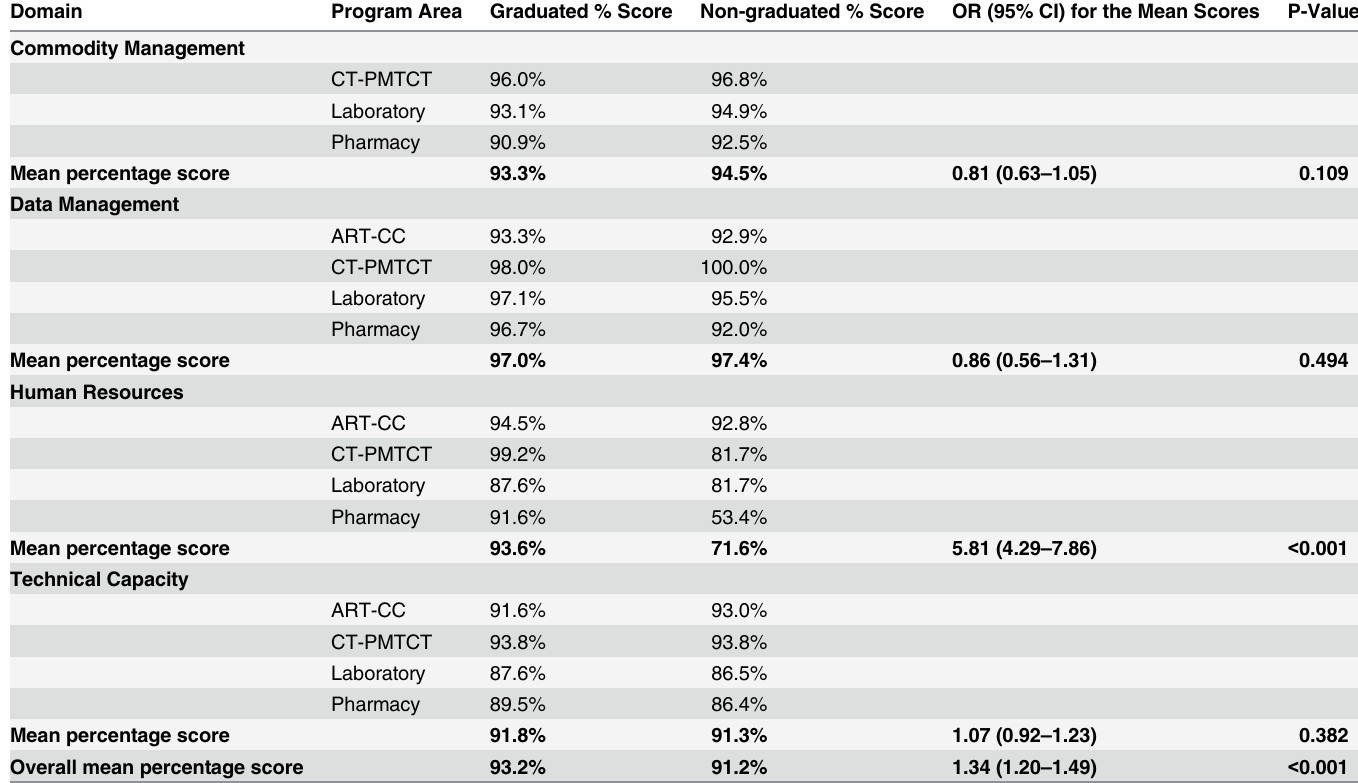
Table 3. District Graduation Performance in four Performance